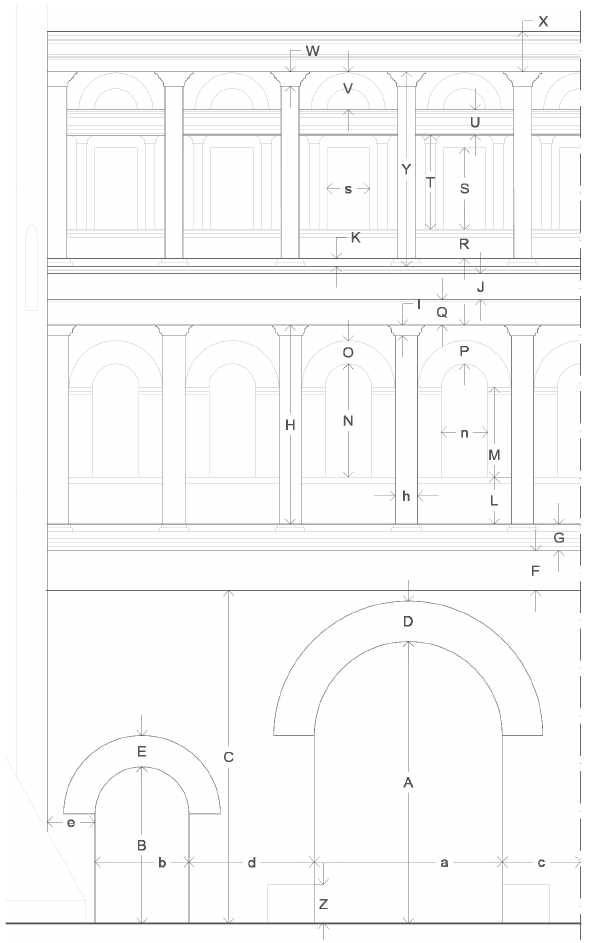
Figure 10 . Legend of encoded measures © E. C. Giovannini The dimensions found on RIBA 31826 were indexed, using alphabetic characters. In the case of dimensions for horizontal distance, lower case letters were used, while for vertical ones, upper case letters were